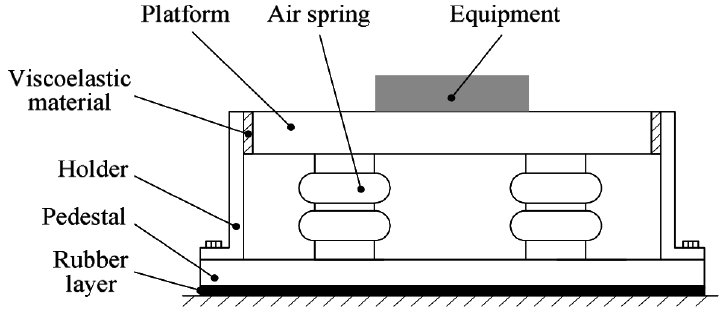
Figure 3. Bionic vibration control system using viscoelastic materials [44].